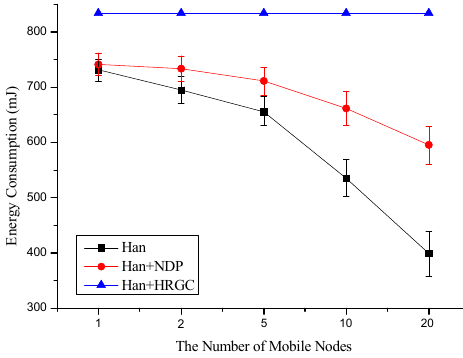
Figure 9. Energy consumption vs. the number of mobile